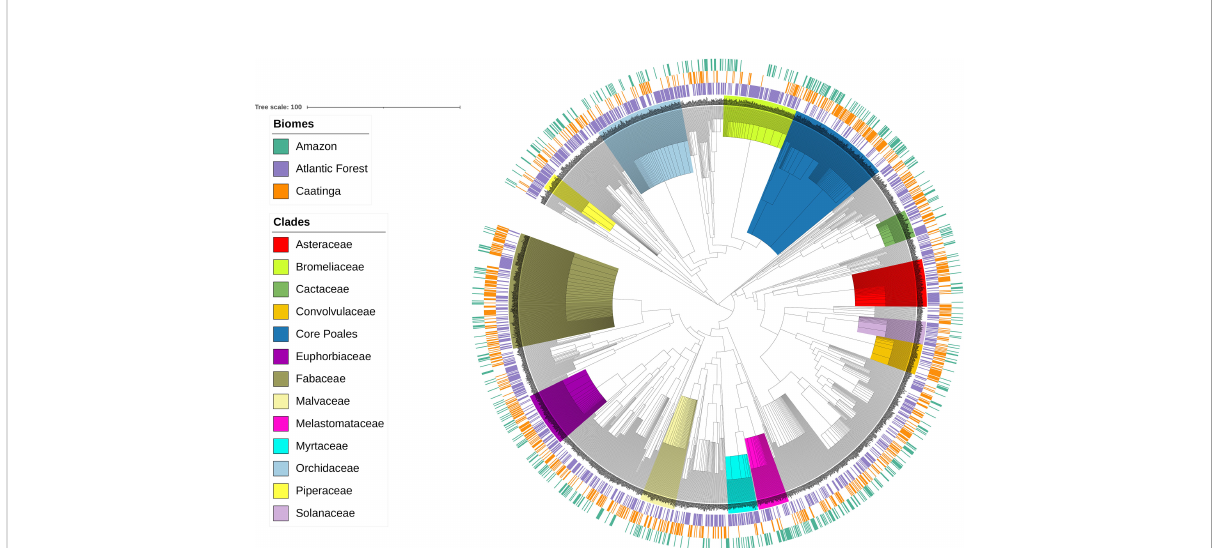
FIGURE 2 The inselberg megatree indicates the different biomes of 2193 species: the outer ring (orange) represents the Caatinga inselbergs, the middle ring (mauve), the Atlantic Forest inselbergs, and the inner ring (green) the Amazonian inselbergs. The plant groups mentioned in the results and discussion are